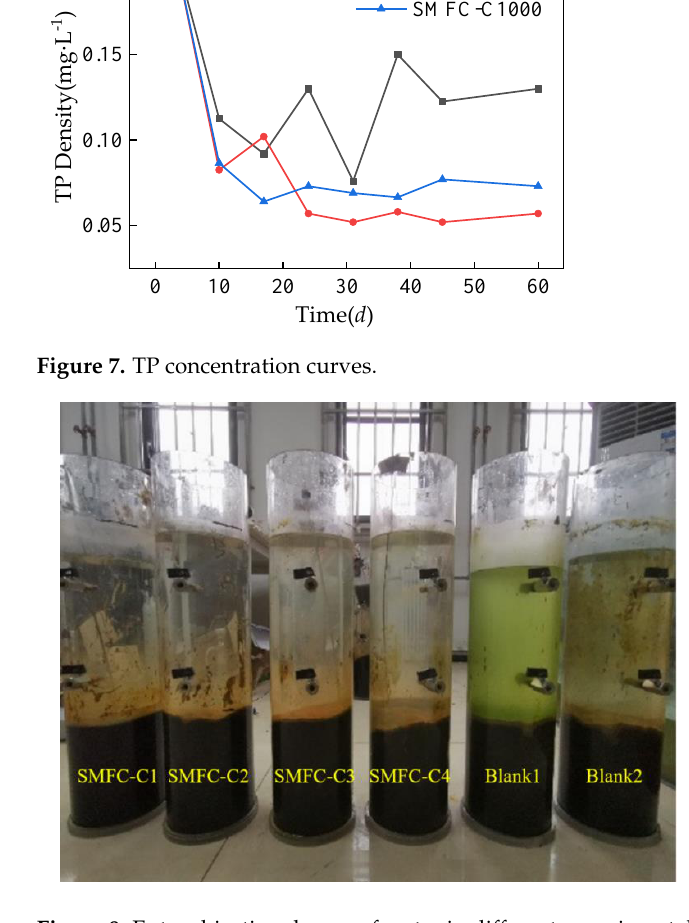
Figure 7. TP concentration curves.